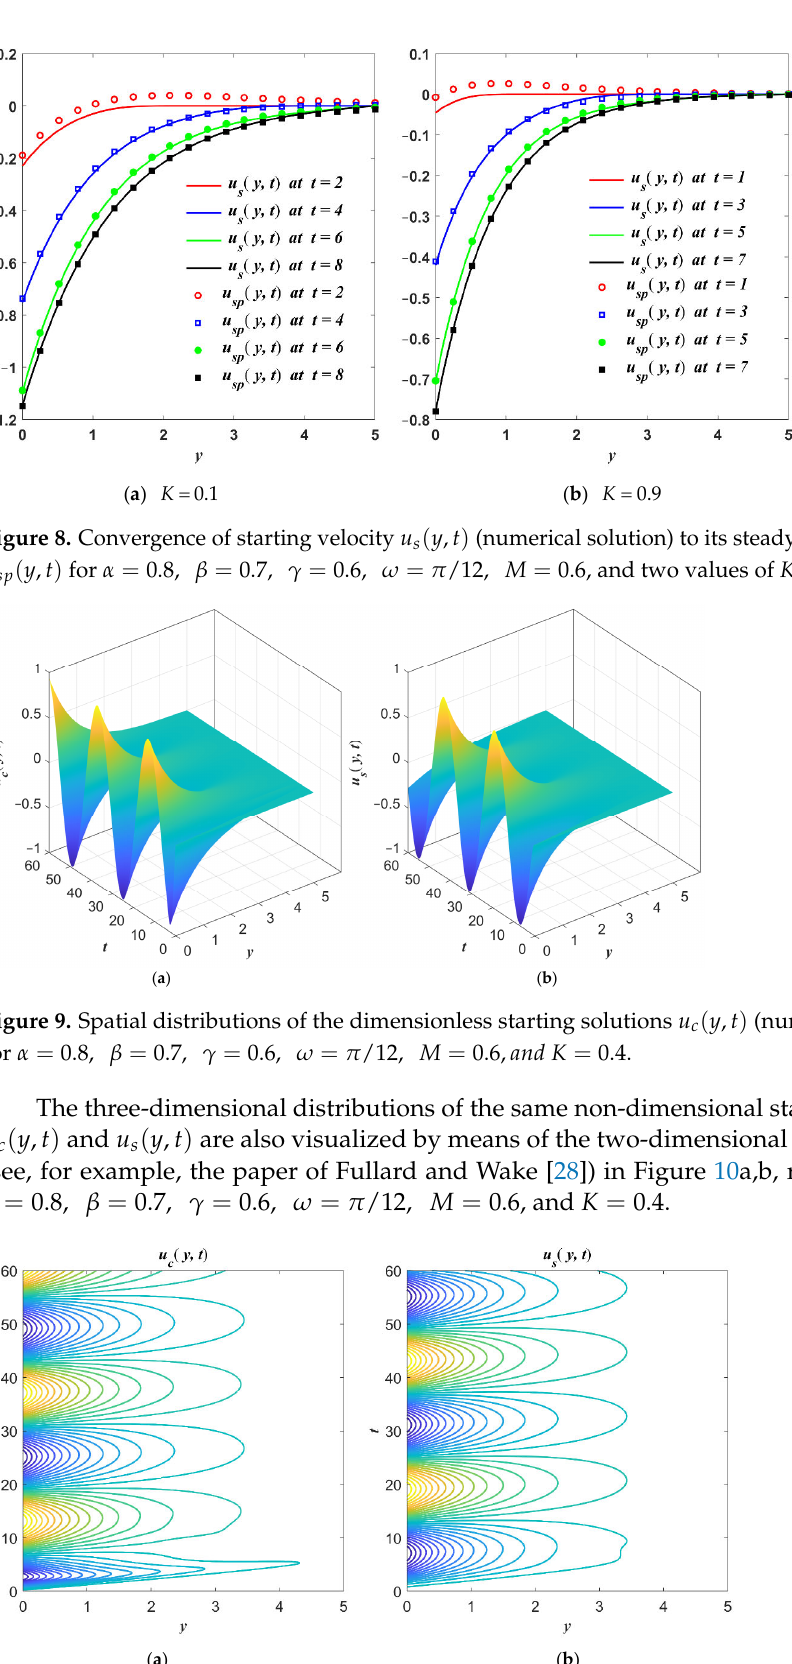
Figure 7. Convergence of starting velocity ),( tyu c (numerical solution) to its steady ‐ state component ),( tyu cp for 6.0,12/,6.0,7.0,8.0  M  , and two values of K .